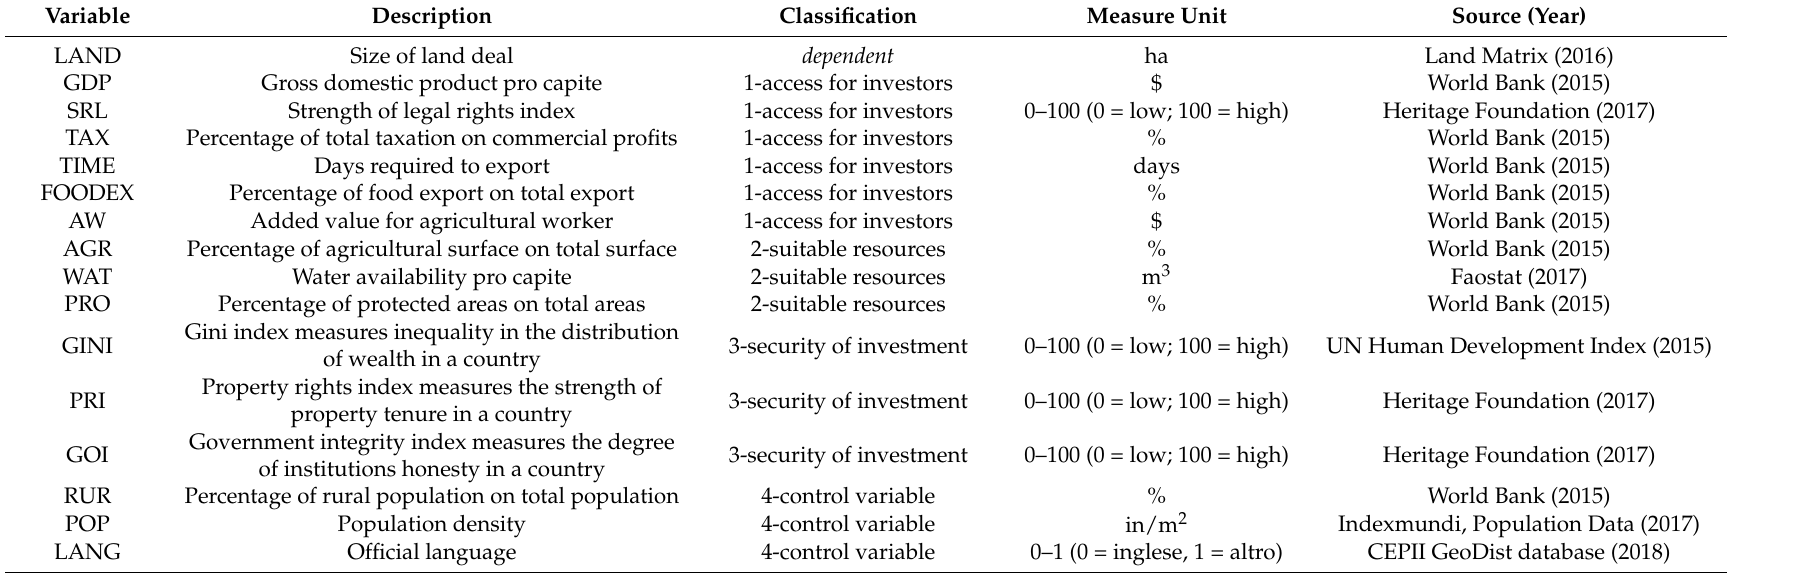
Table 1. Description of